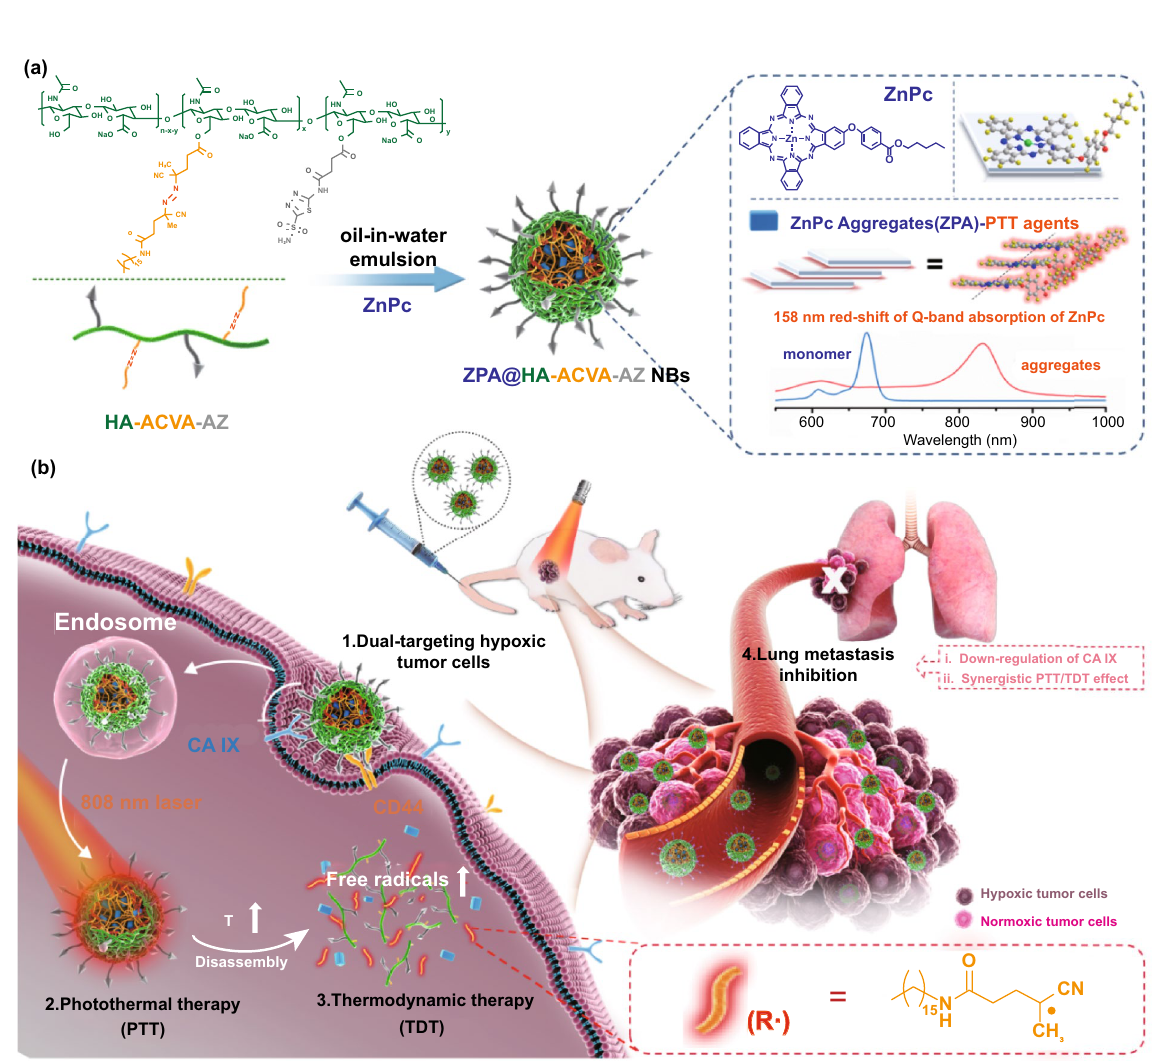
Fig. 1 a Schematic illustration of the fabrication of ZPA@HA-ACVA-AZ NBs through oil-in-water emulsion method and formation of special ZnPc aggregates (ZPA) in the core of nanobullets. b Mechanistic action of ZPA@HA-ACVA-AZ NBs for synergistic photothermal thermody- namic therapy and lung metastasis-inhibition. The CD44/CA IX dual-targeting ZPA@HA-ACVA-AZ NBs display the enhanced accumulation in hypoxic tumors. Upon 808-nm laser irradiation, the light-induced heat and heat-induced alkyl radicals could synergistically induce cell death and suppress cancer metastasis via synergistic PTT/TDT and CA IX